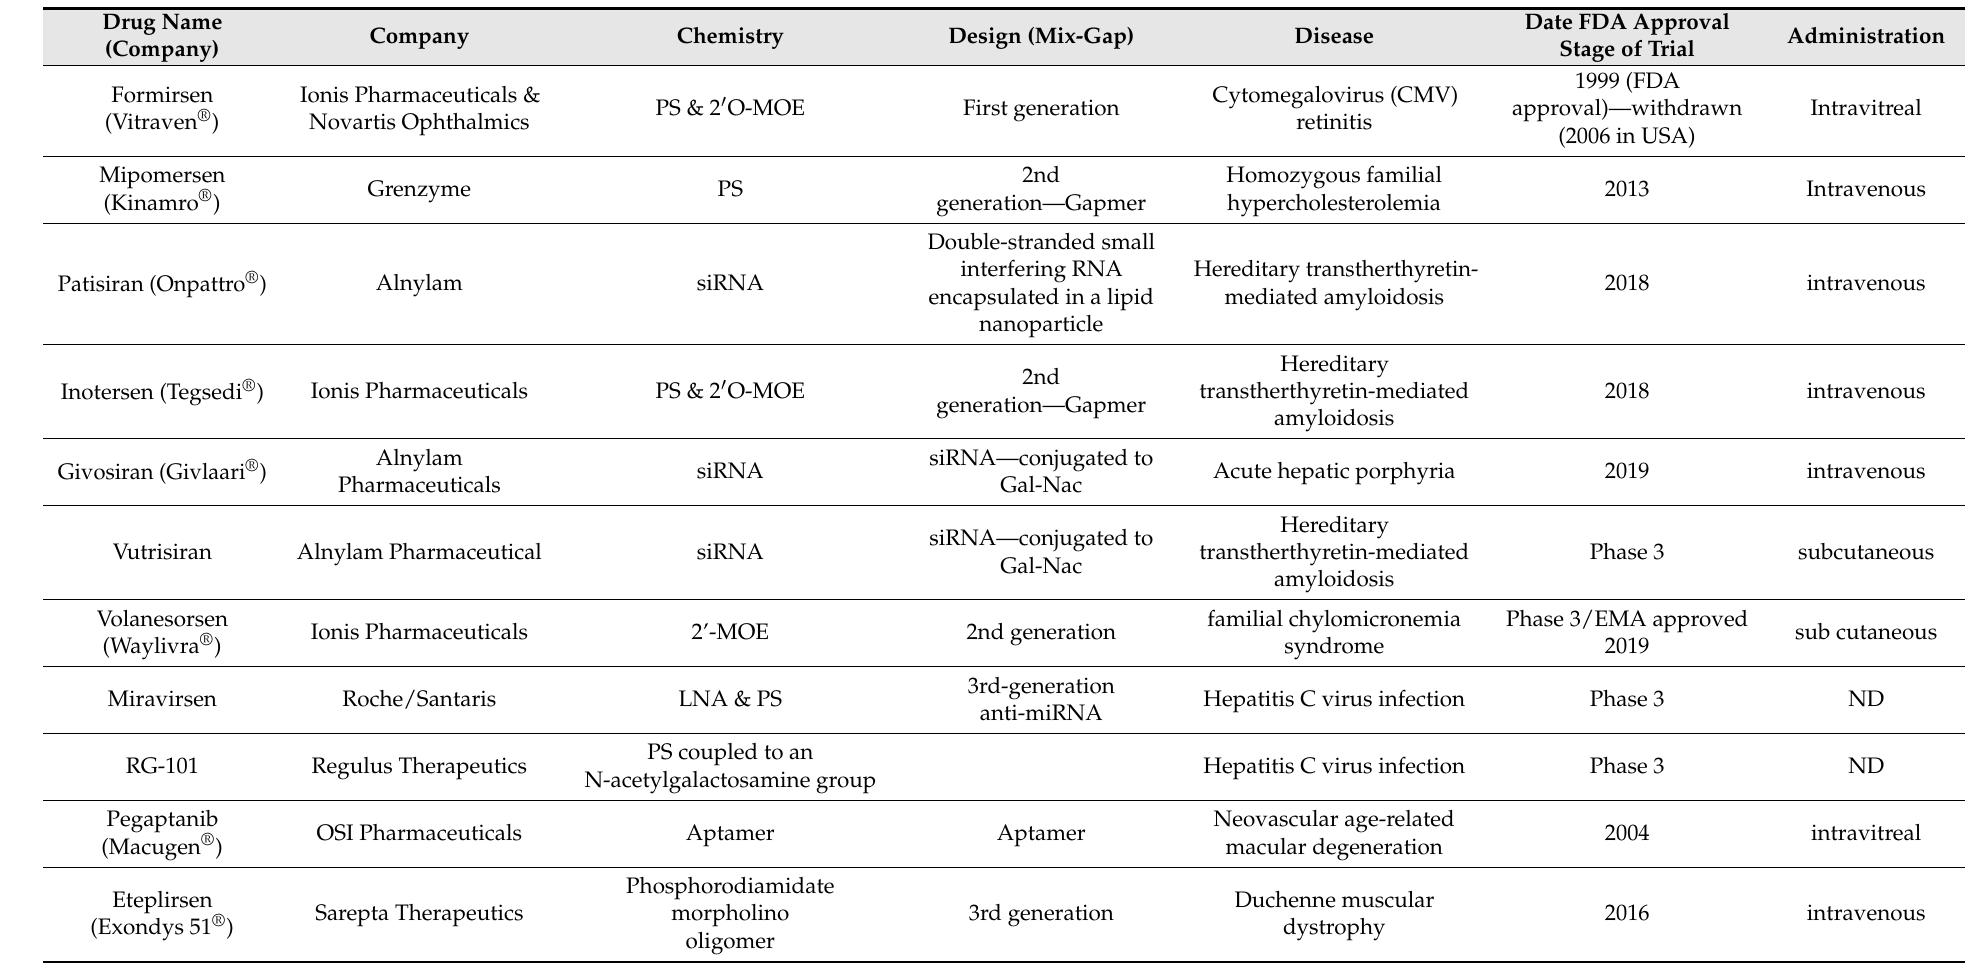
Table 1. Drugs based on ASO technology that have already received FDA approval or are at the latest stages of clinical